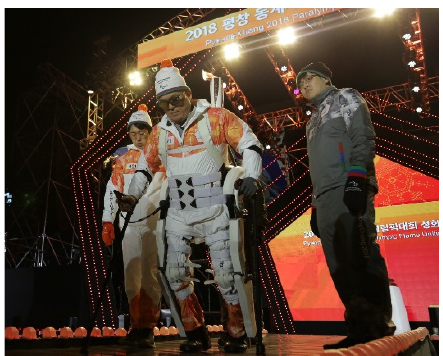
Figure 1. A complete paraplegic wearing the WalkON Suit for the torch relay of the Pyeongchang Paralympics